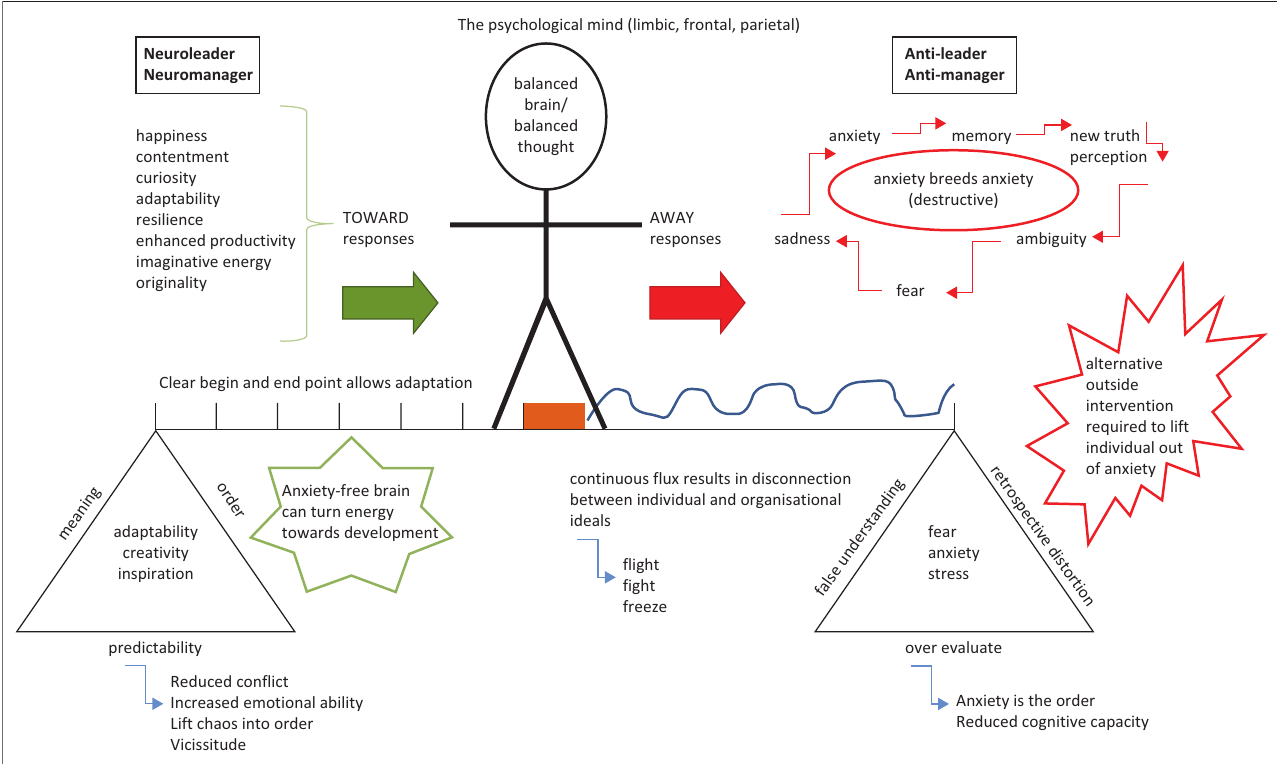
FIGURE 2: Stress and the